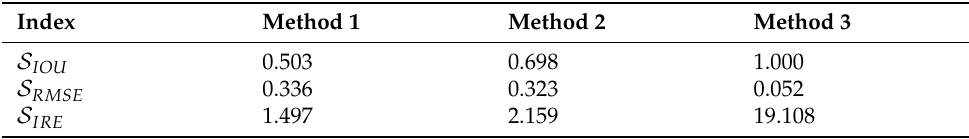
Table 3. Evaluation indexes of inversion results.